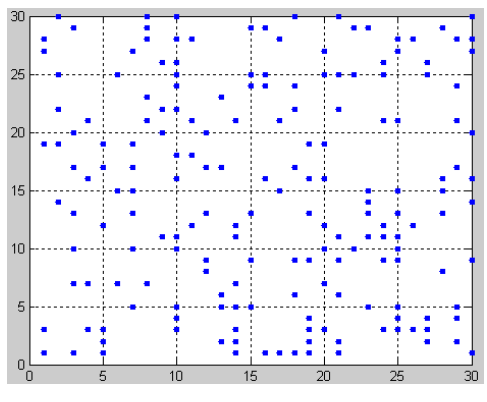
Figure 1. The sensor network with 200 randomly deployed nodes.